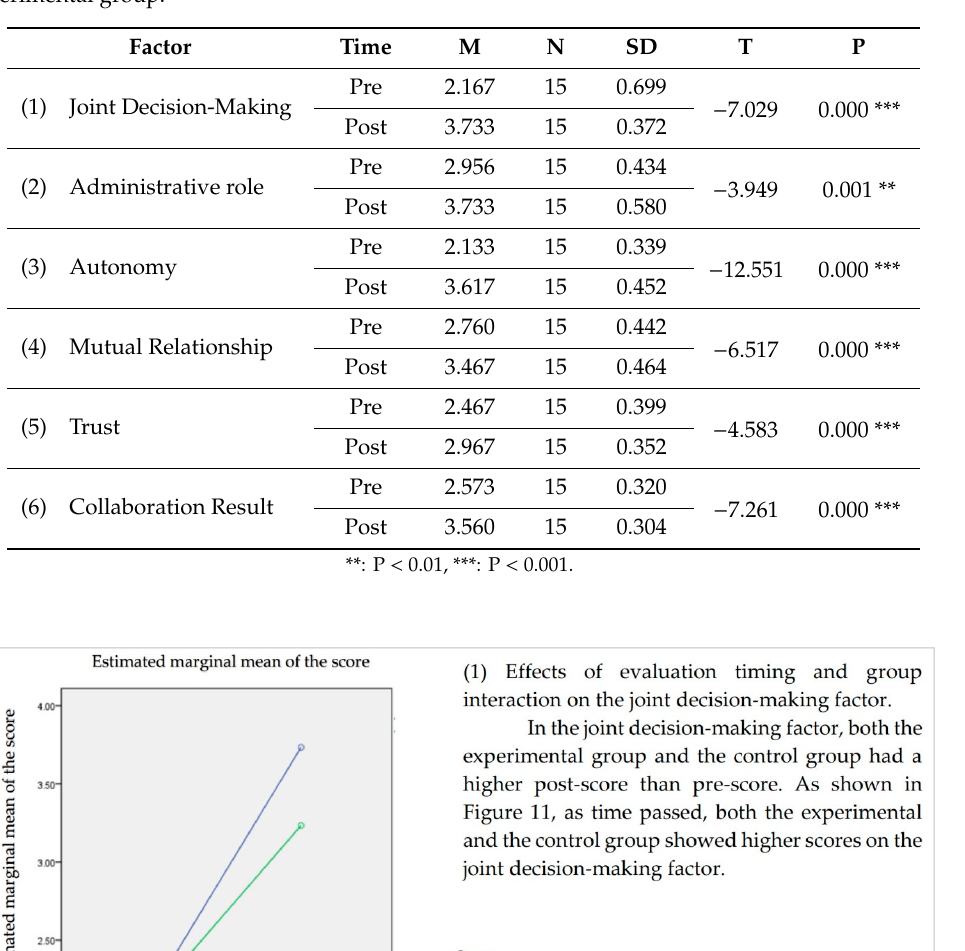
Table 13. Analysis result of di ff erence between pre- and post-scores in the collaboration level of the experimental group.